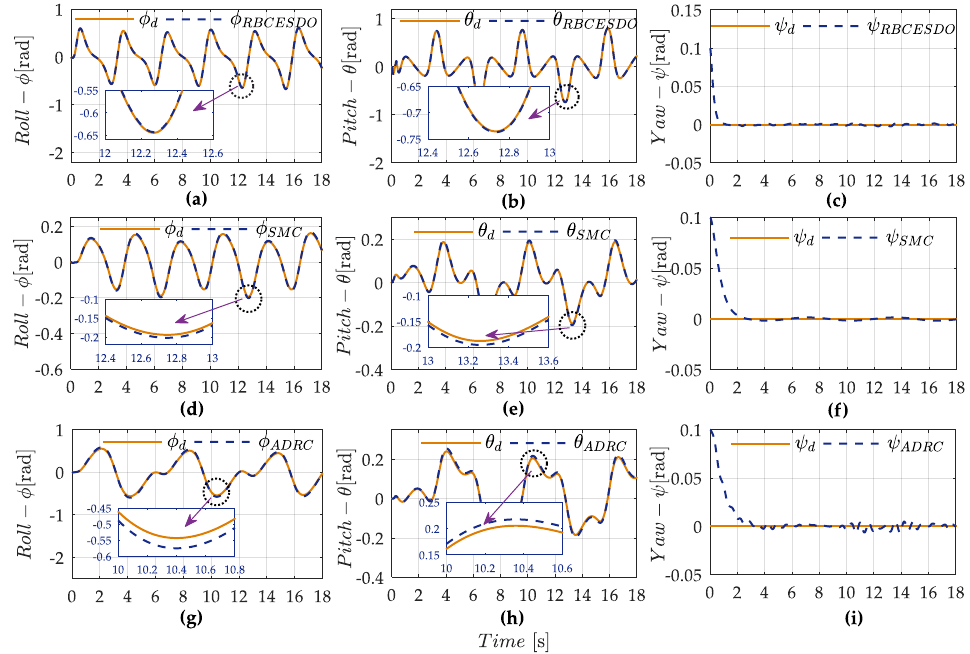
Figure 5 . Comparison of attitude performance between the proposed RBCESDO ( a – c ), SMC ( d – f ), and ADRC ( g – i ).